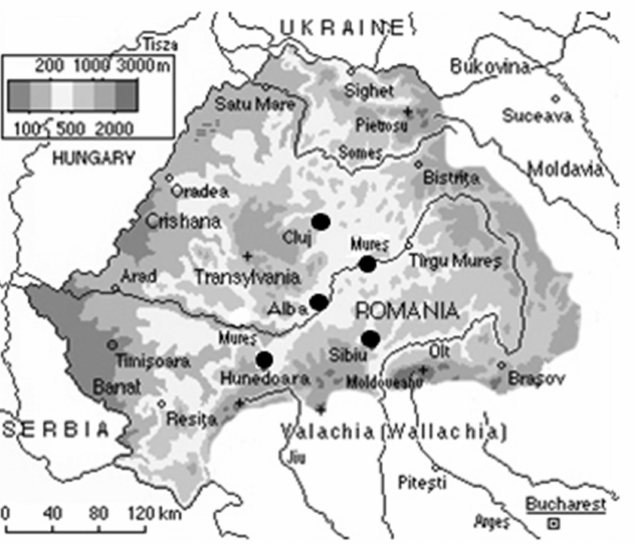
Figure 1. Romanian map highlighting the propolis sampling areas (Alba—S1, Cluj—S2, Hunedoara— S3, Sibiu—S4, Mures ,